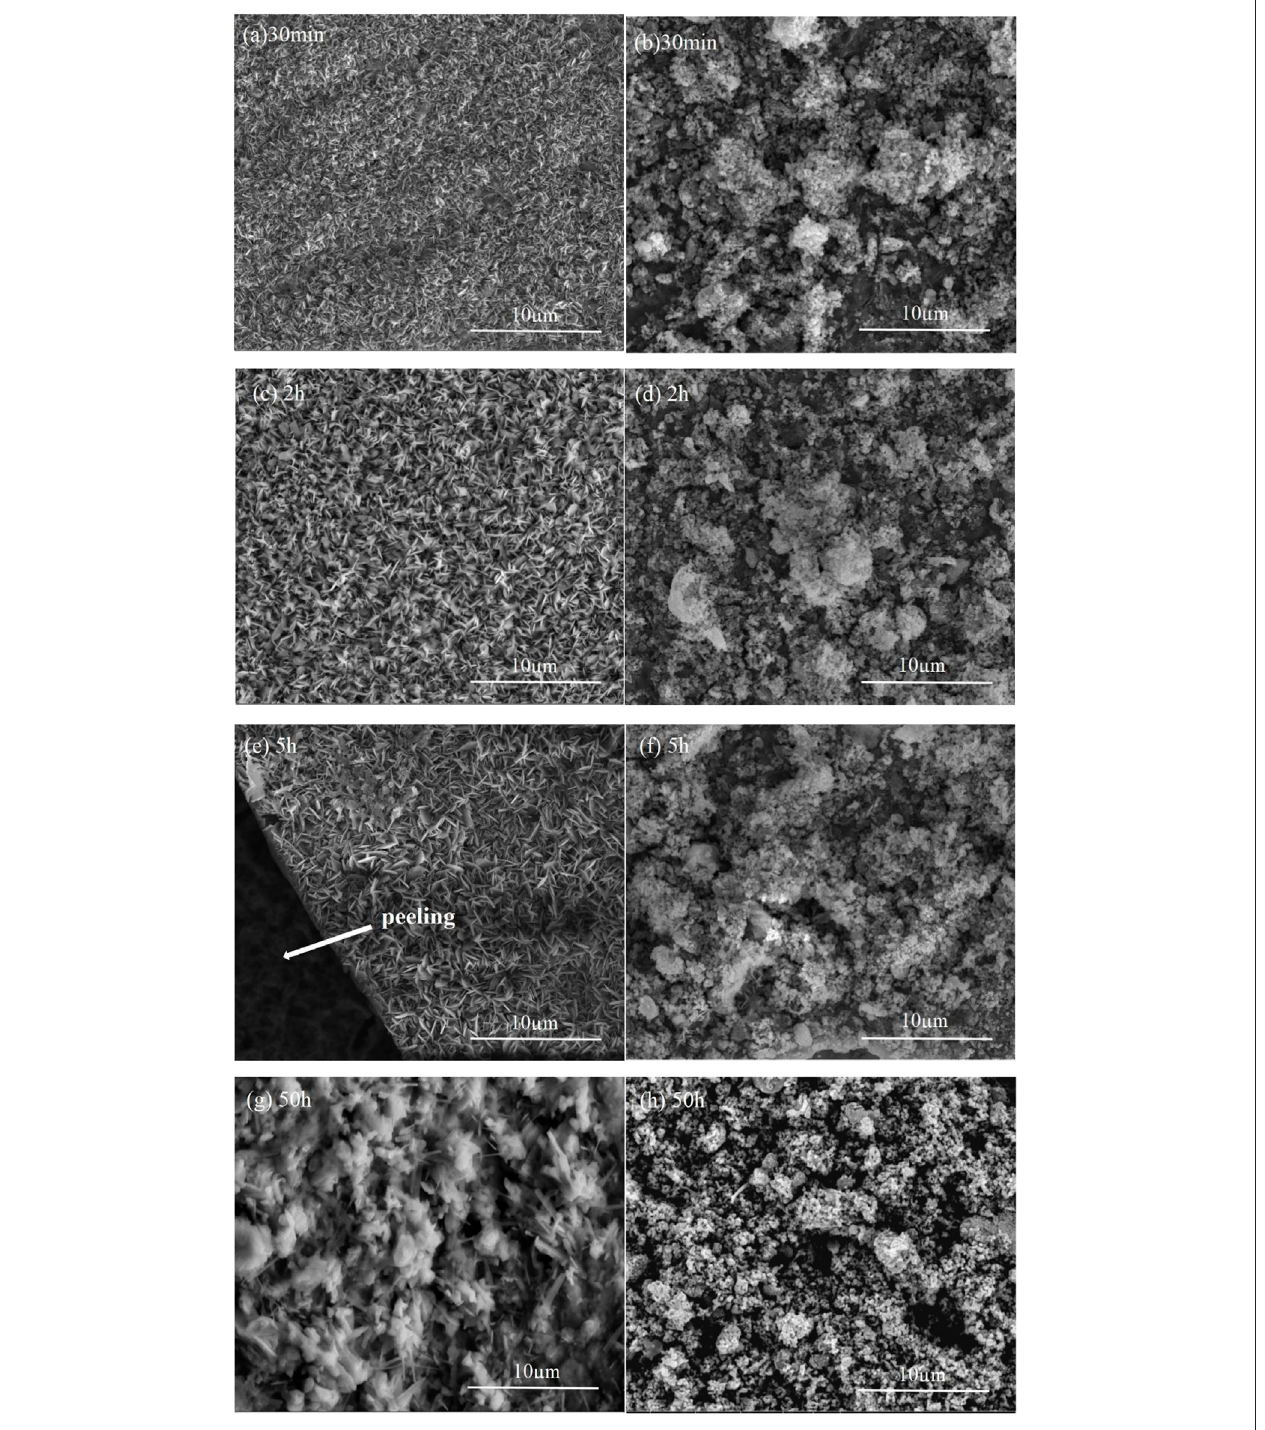
FIGURE4| Surfacemorphologiesofthealuminascaleformedonthe δ -Ni 2 Al 3 coatingat1,000 ° Cfordifferentoxidationtimes. (A) , (C) , (E) ,and (G) :Ni 2 Al 3 ; (B) , (D) , (F) , and (H) : Al 2 O 3 fi lm – covered Ni 2 Al 3 .